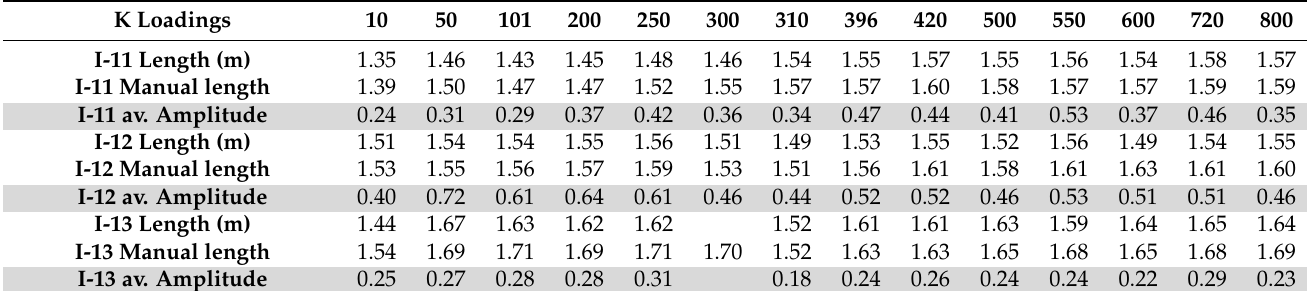
Table 3. Detected characteristics of defect zones from 2.6 GHz longitudinal B-scans.